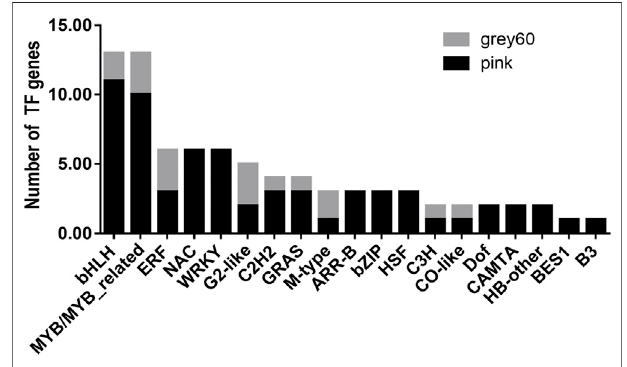
FIGURE 6 | The distribution of TFs in the positive correlation modules and the construction of co-expression network. Types and numbers of transcription factors (TFs) genes in “ grey60 ” and “ pink ” modules.